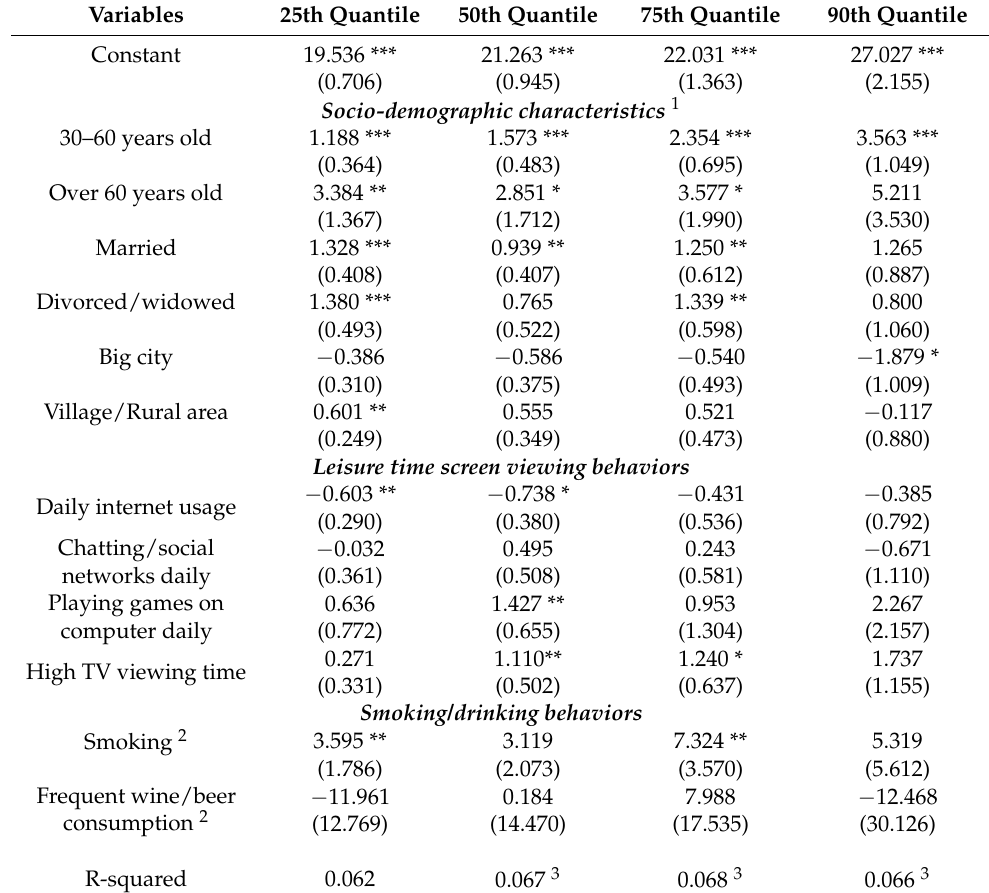
Table 6. Quantile regression estimates for female participants’